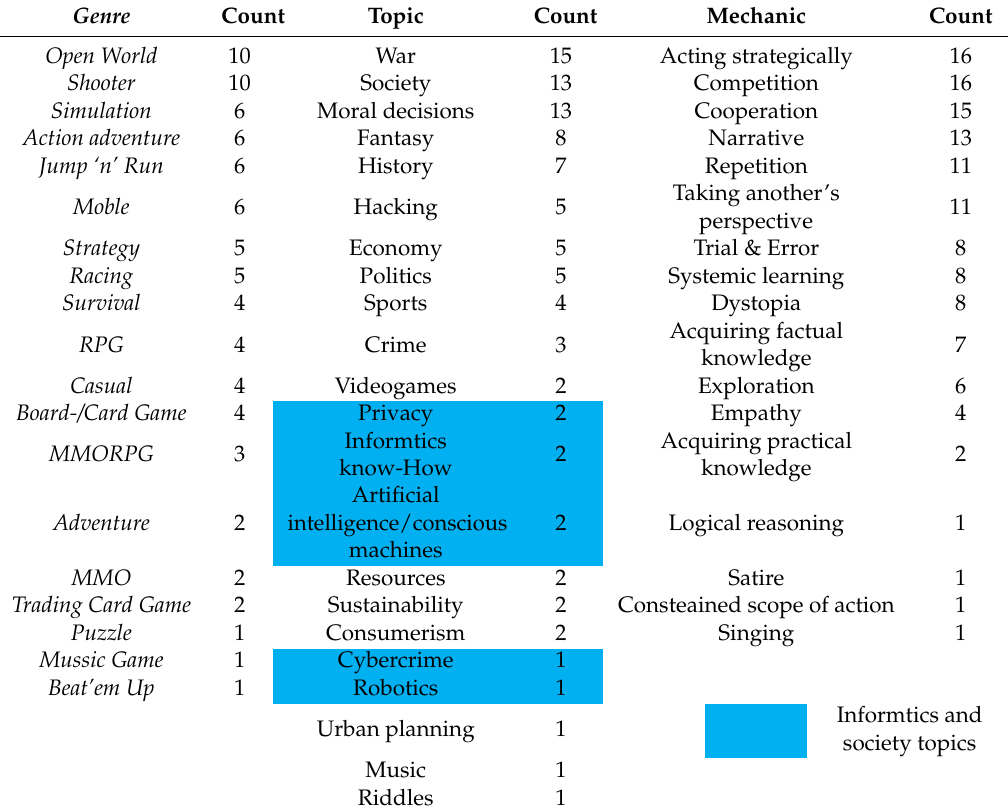
Table 1. Overview of the analysis of genres, topics and mechanics in the Sparkling Games